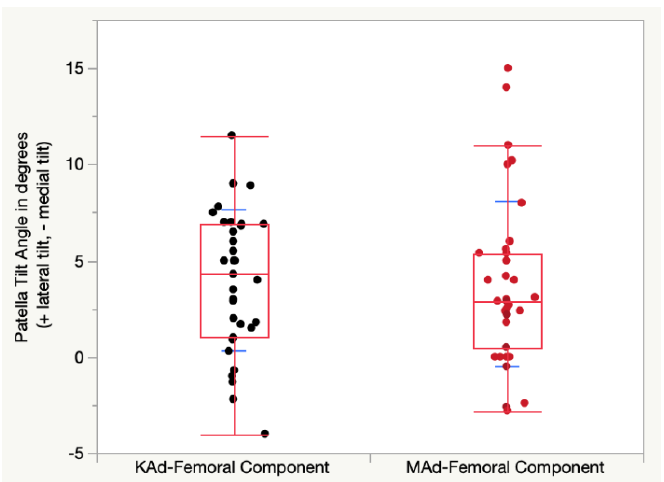
Figure 6. Quantile box plot shows the lateral undercoverage of the anterior femoral resection for the KA D - (black points) and MA D -FC (red points). Standard deviations are illustrated by blue lines. The KA D -FC’s mean 4 ± 3.7 ◦ of lateral patellar tilt was not different from the 3.8 ± 4.3 ◦ The KA D - FC’s mean 4 ± 3.7°of lateral patellar tilt was not different from the 3.8 ± 4.3° of lateral patellar tilt for the MA D -FC ( p = 0.5296). (Figure 7). of lateral patellar tilt for the MA D -FC ( p = 0.5296). (Figure 7).